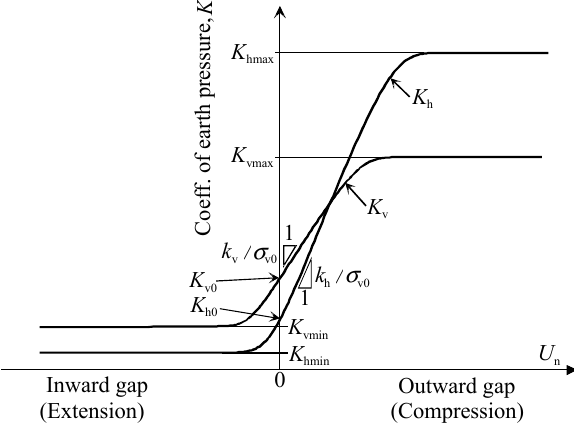
Figure 3. Ground reaction curves (GRC).